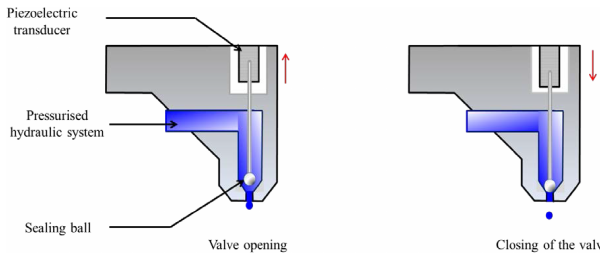
Figure 2. Diagram of operation of the generator opening valve.